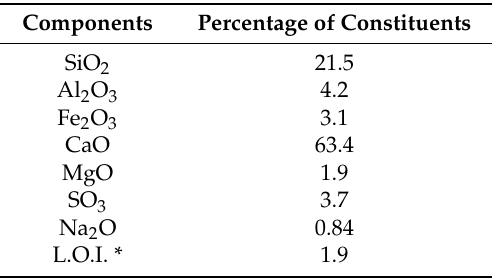
Table 1. Chemical characteristics of Tehran Portland cement type II.